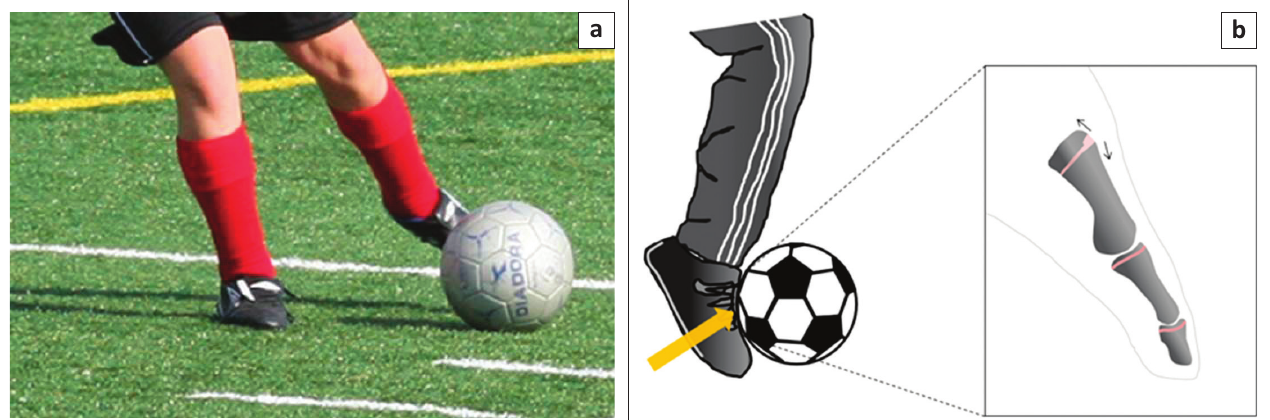
FIGURE 4: Photograph (a) and diagram (b) illustrate a possible mechanism for the dorsal physeal widening seen in our patient. We postulate that kicking of a soccer ball imparts a tension force on the dorsal aspect of the physis. Upon repetition, this can result in physeal distraction and subsequent stress injury, similar to other chronic physeal stress changes, such as the one shown in ‘Little Leaguer’s shoulder’ (Figure 3b) or